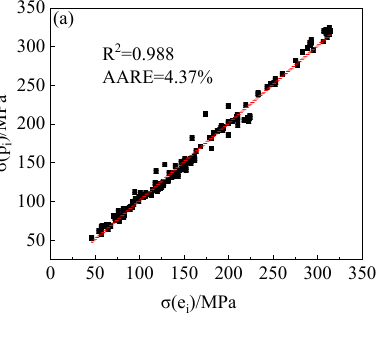
Figure 17. The relative error curves of the prediction results: ( a ) the Arrhenius-type model, ( b ) the modified Arrhenius-type model.